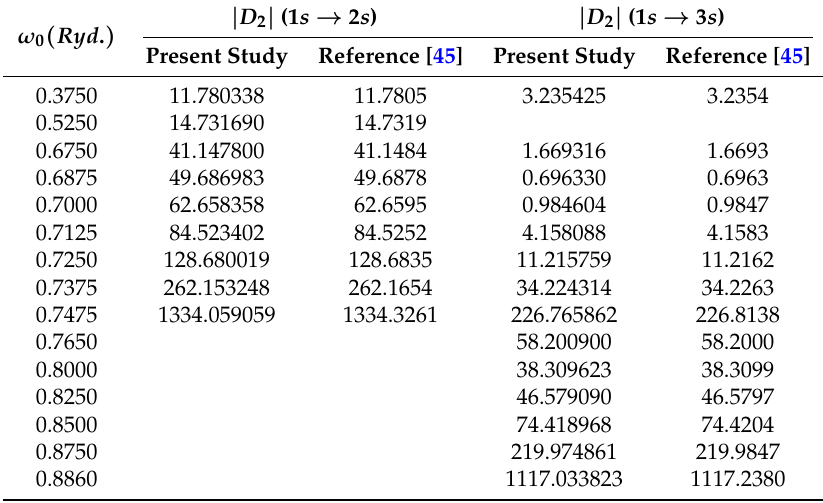
Table 1. Comparison of | D 2 | for free hydrogen with results available in [45].